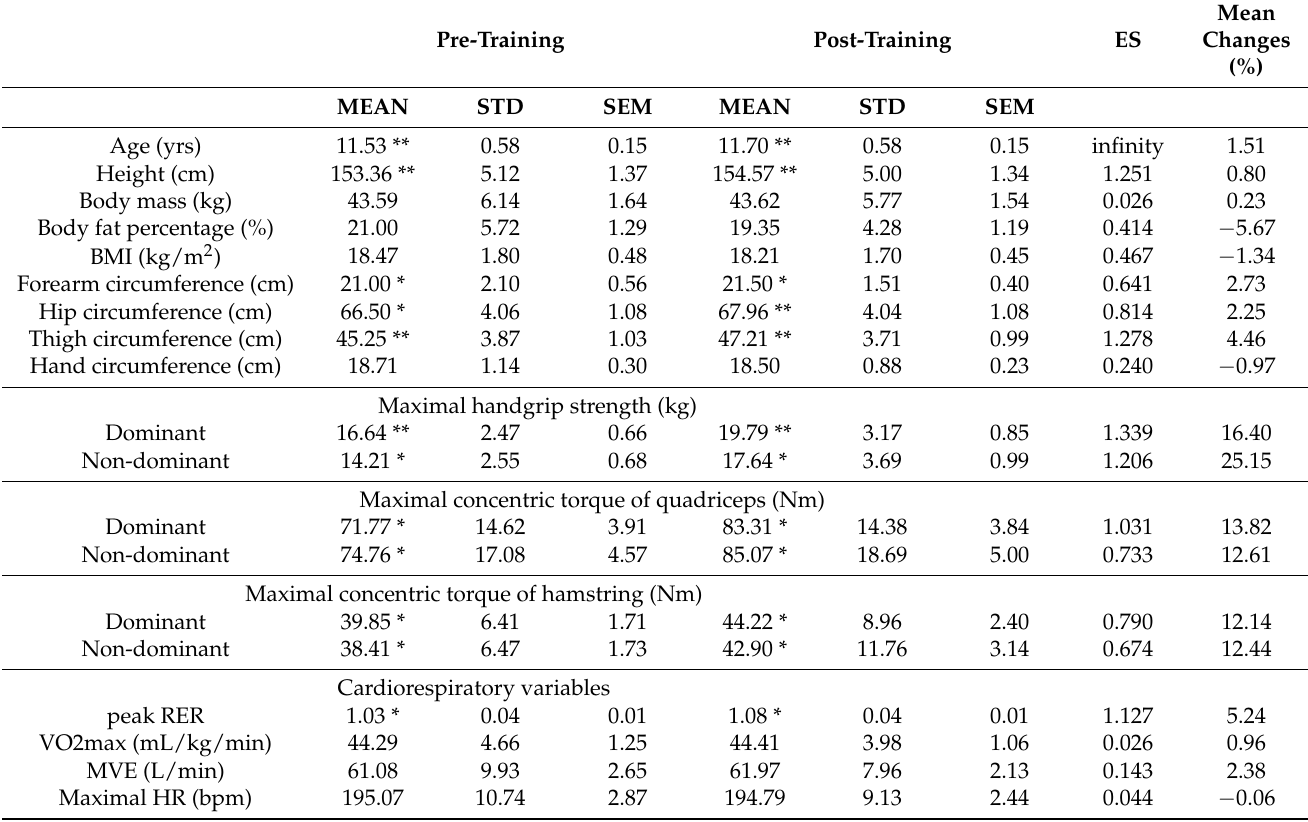
Table 1. Anthropometric parameters, physical characteristics and cardiorespiratory variables among handball players prior to and following the 8-week training